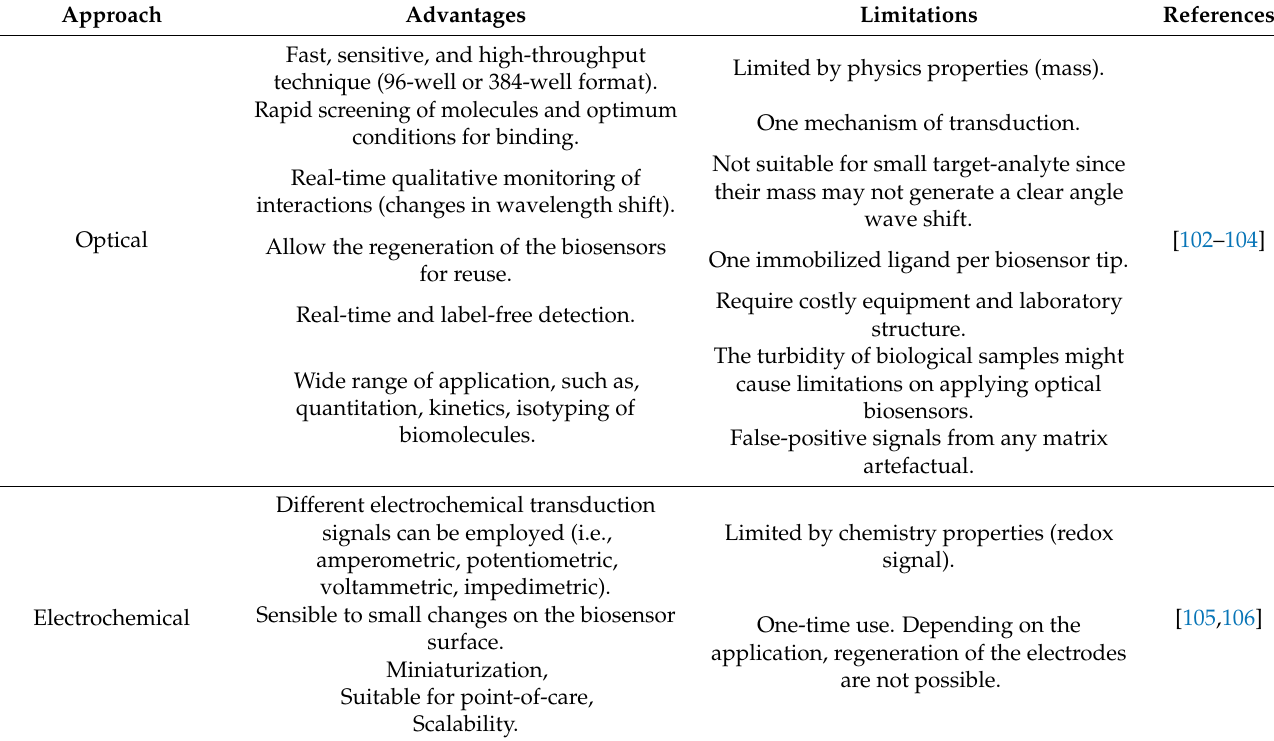
Table 2. Advantages and limitations of optical and electrochemical